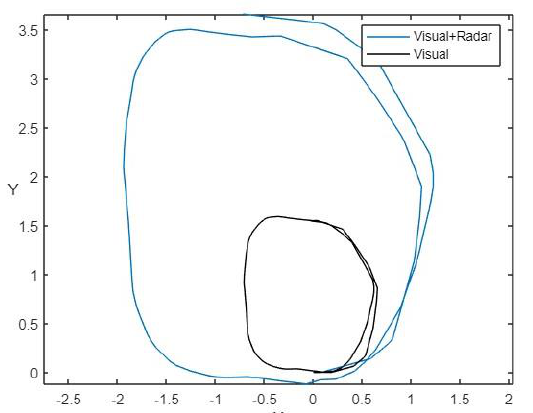
Figure 10. The comparison of trajectory between Radar Aided VO and pure VO in scenario 2 (Conference room) In Figure 9, pure VO trajectory travels only 5 m. But with the linear velocity estimated by the radar, the travel distance is about 18 m, which is closer to the length of the hallway. In Figure 10, pure VO travel through the area for about 1 × 1.5⁡m , and the area expand to 3 × 3.5⁡m with the aid of Radar. These result clearly shown the Radar aided VO is cabable of recovering the scale of true world for Monocular VO.